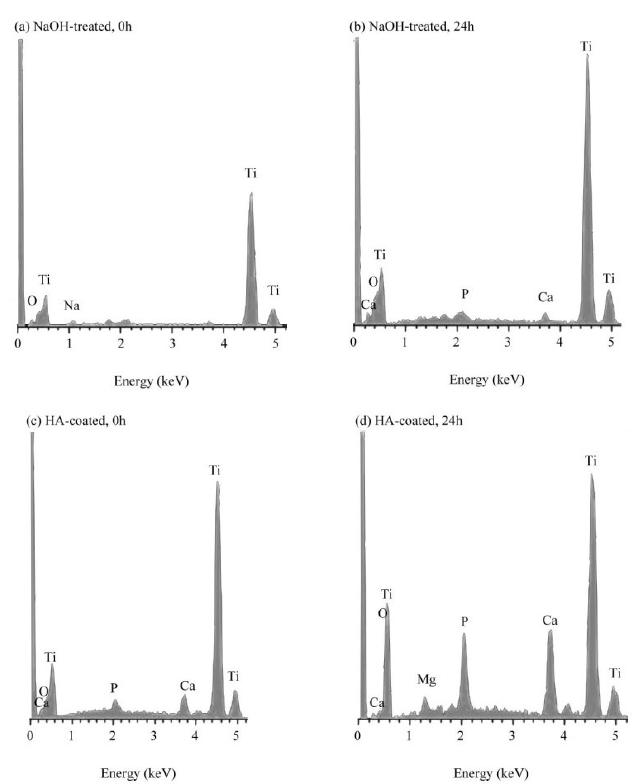
Figure 7. Energy-dispersive X-ray spectroscopy (EDS) of the surfaces of NaOH-treated c.p. Ti ( a , b ) and HA-coated c.p. Ti ( c , d ) subjected to heat treatment at 500 ◦ C for 2 h before and after subsequent soaking in SBF for 24 h.